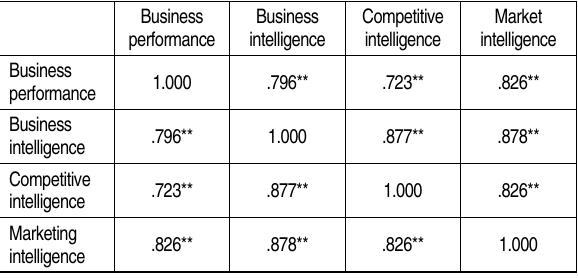
Table 6. Correlation coefficients